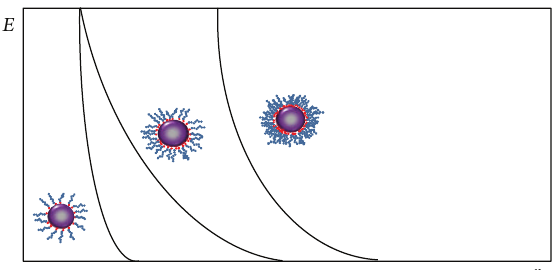
Figure 5: Interaction energy ( 𝐸 ) as a function of distance ( 𝑟 ) separating colloidal particles due to the steric hindrance caused by brushes of grafted polymer layers on their surfaces, increasing the length of the polymer, that is, the degree of polymerization and the number of grafted chains per particle. Adapted from [8].